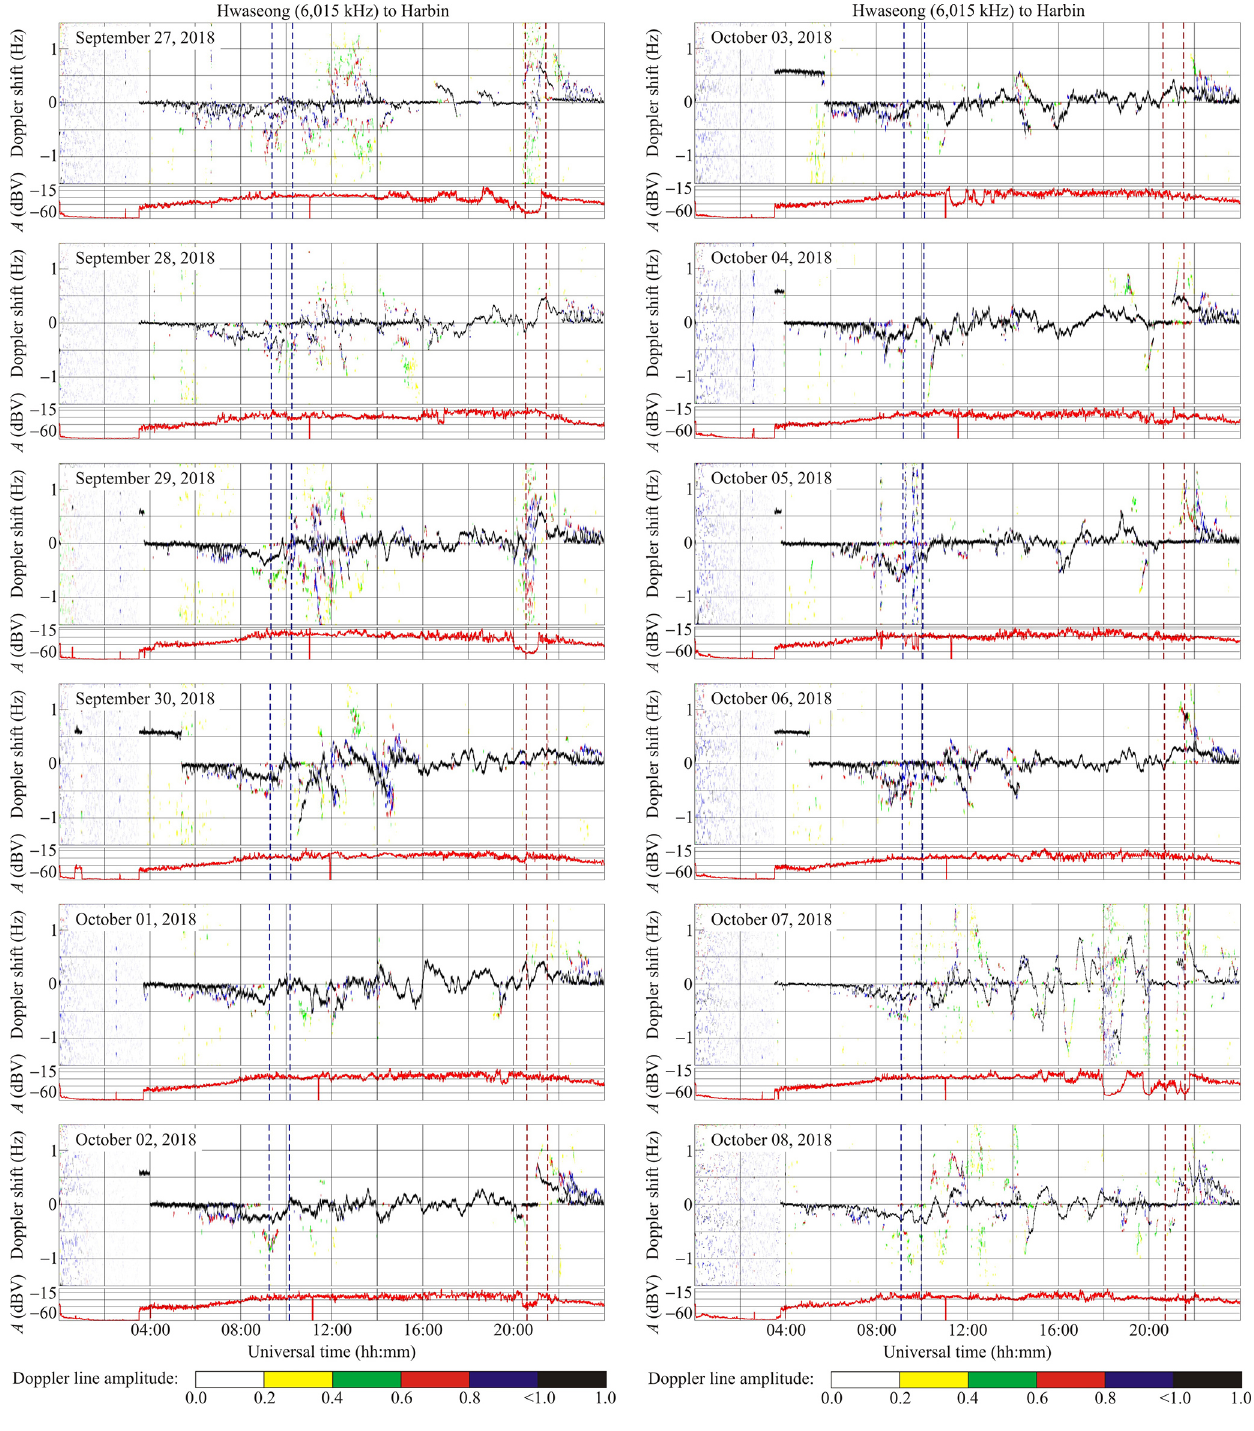
Figure 6. Universal time variations in the Doppler spectra and relative signal amplitude, A , along the Hwaseong to Harbin propagation path for the 27 September–2 October and 3–8 October 2018 periods. Vertical dashed lines designate instances of sunrise (two right-hand red lines) and sunset (two left-hand blue lines) at the ground and at 100km altitude. The signal amplitude, A , at the receiver output in decibels, dBV (relative to 1V), is shown below the Doppler spectra in each